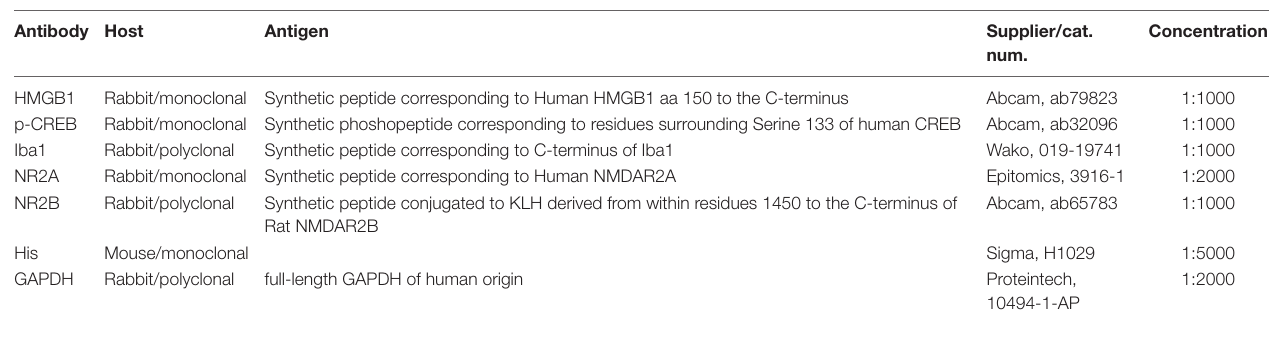
concentration num.